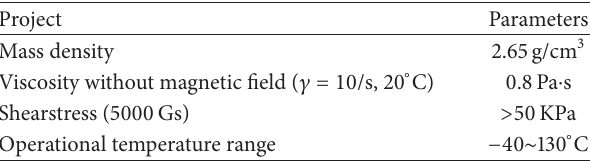
Table 1: Performanceindex of MR fluid with MRF-J01T.